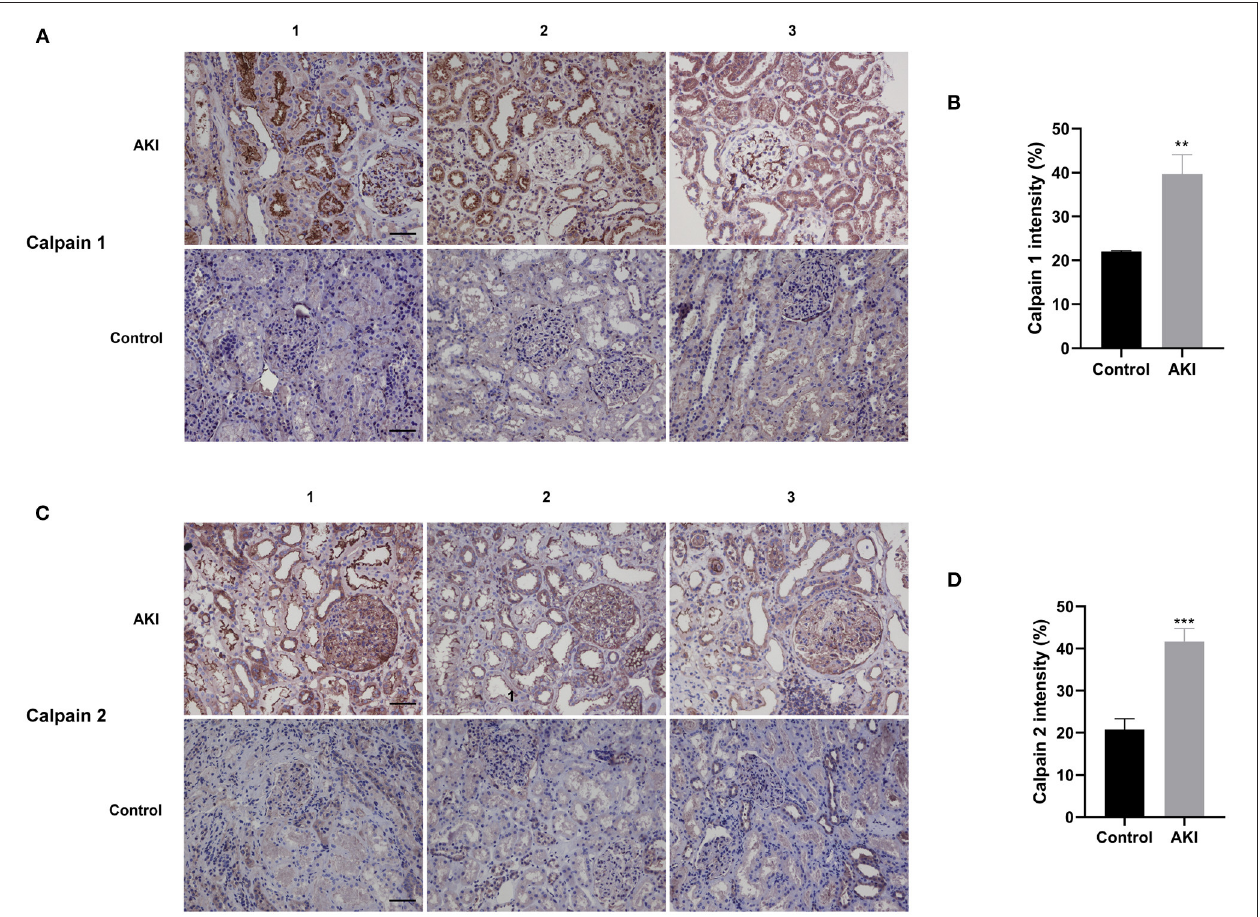
FIGURE 1 | Calpain 1 and 2 are markedly increased in the renal biopsy of AKI patients. Representative immunohistochemical micrographs of Calpain 1 (A) and Calpain 2 (C) protein expression in the renal biopsy of both AKI patients ( n = 10) and normal control group ( n = 6). Quantitative analysis of Calpain 1 (B) and Calpain 2 (D) expression in the human renal specimens. × 200, bar = 100 µ m. Data were presented as mean ± SEM ( n = 3). ** p < 0.01; *** p < 0.001 vs. normal control group. AKI, acute kidney